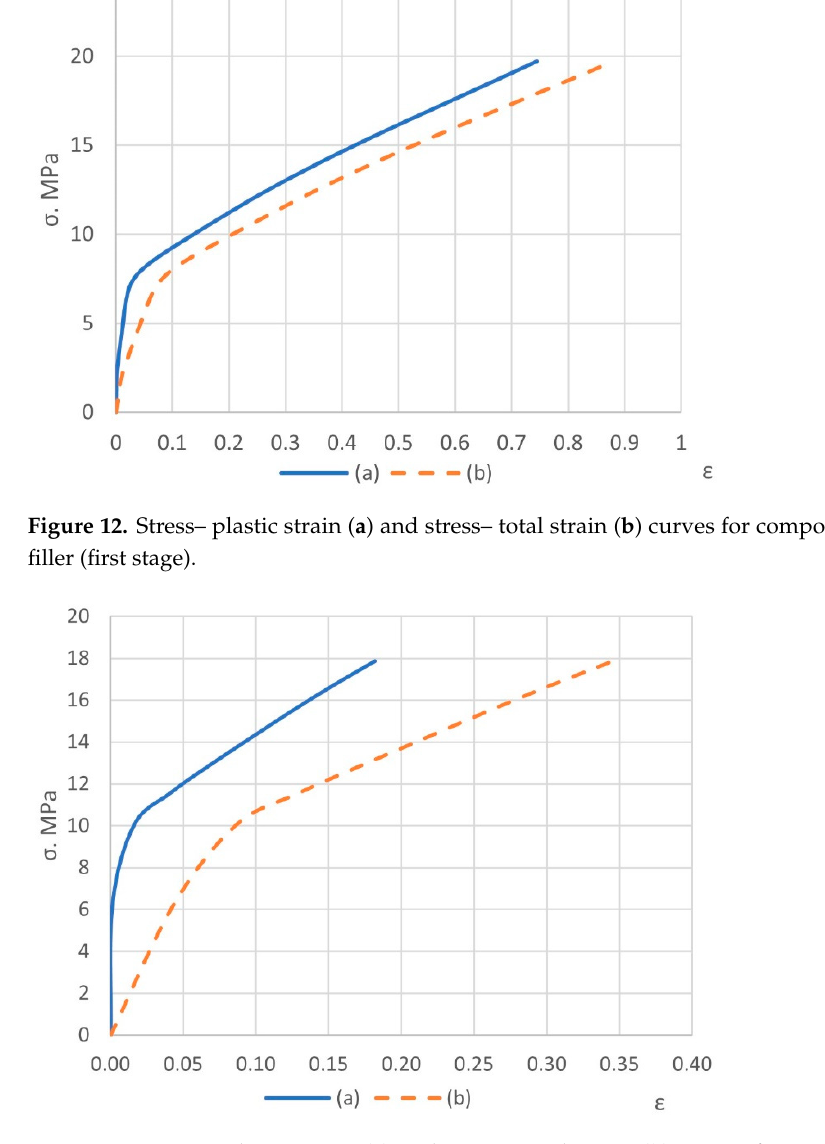
Figure 13. Stress– plastic strain ( a ) and stress– total strain ( b ) curves for composite with short cylindrical filler (first stage).